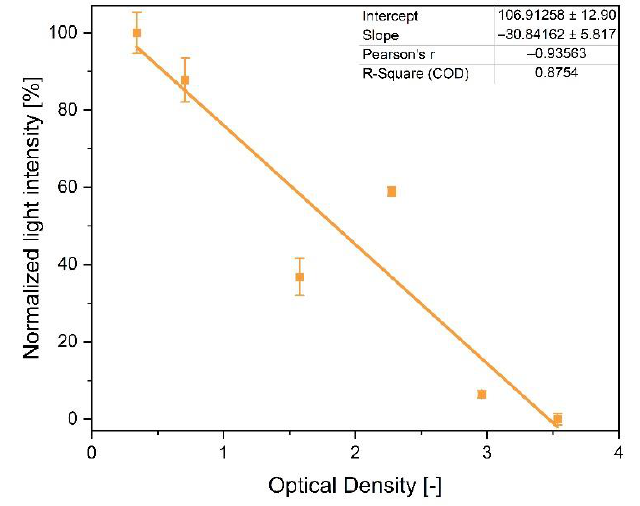
Figure 3. Normalized light intensity, measured by a spectrometer, of E. coli culture suspensions with optical densities between 0.5 and 3.5 in the cwMBR. A blue LED over the cwMBR was used as the light source, and a spectrometer was used as the read-out device.